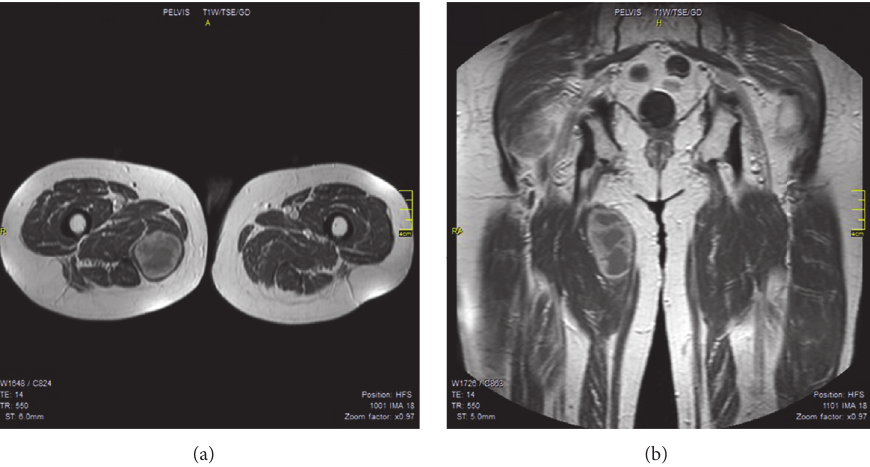
Figure 1: Axial (a) and coronal (b) T1 views of an MRI of the lesion in the context of the right adductor magnus muscle, with sparse areas of necrosis and irregular contrast enhancement.